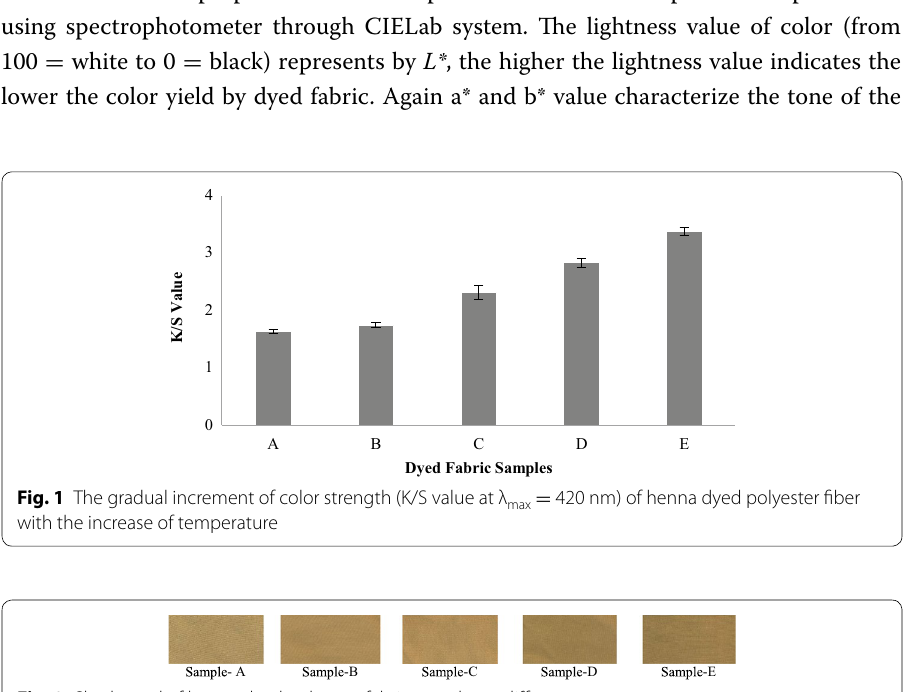
Fig. 2 Shade card of henna dyed polyester fabric samples at different